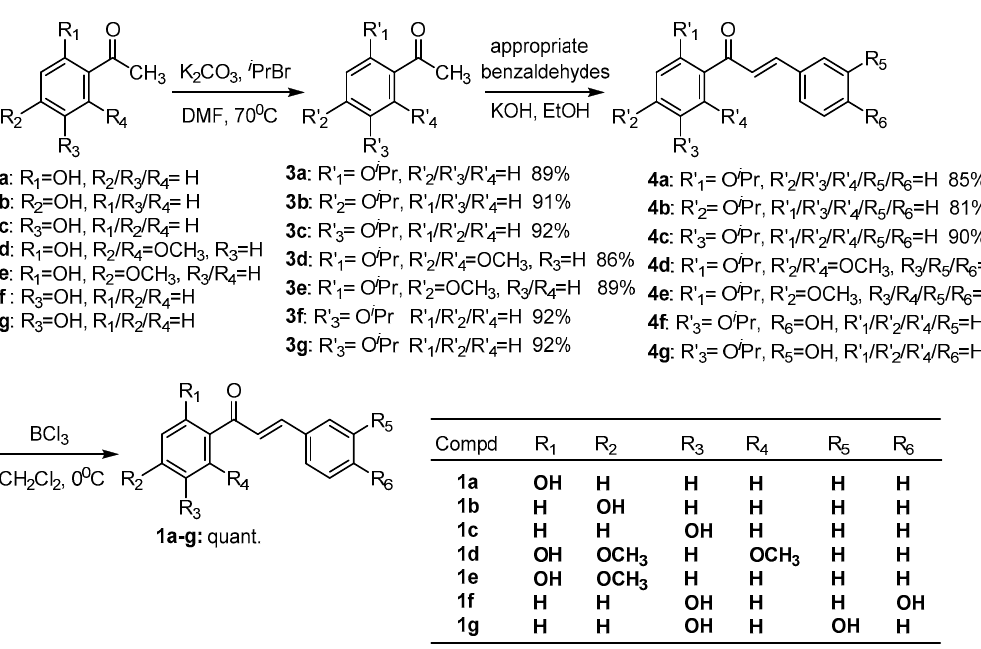
Figure 1. List of chalcone derivatives 1a – t .